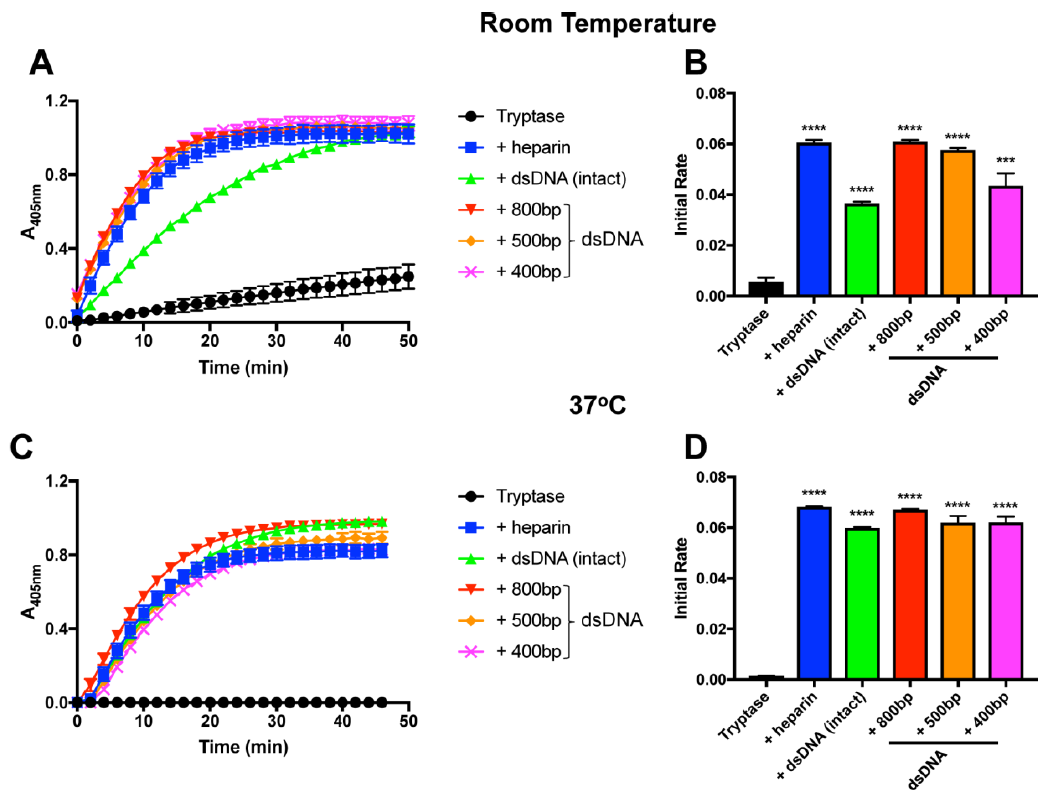
Figure 3. Fragmented DNA stabilizes tryptase activity. β -tryptase (0.07 µg) was incubated at room temperature ( A, B ) or 37 °C ( C, D ) in the absence or presence of either heparin, intact dsDNA or fragmented dsDNA of the indicated sizes. Residual tryptase activity was then measured using the chromogenic substrate S-2288. The data are representative of at least 3 individual experiments. Data are given as mean values ± SD ( n = 3) *** p ≤ 0.001 **** p ≤ 0.0001 (Unpaired t -test).